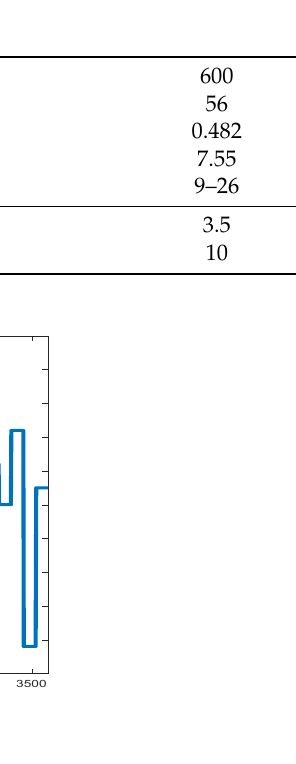
Figure 4. A series of wind speed step changes in one hour.